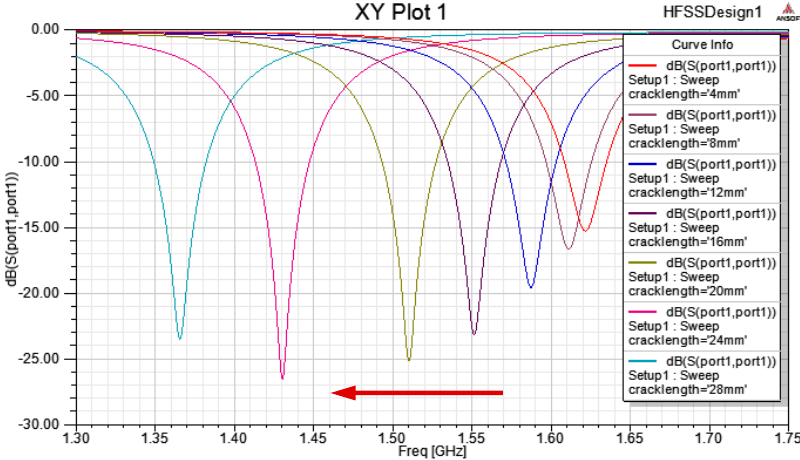
Figure 3. Effects of crack length on the S 11 parameters of the patch antenna